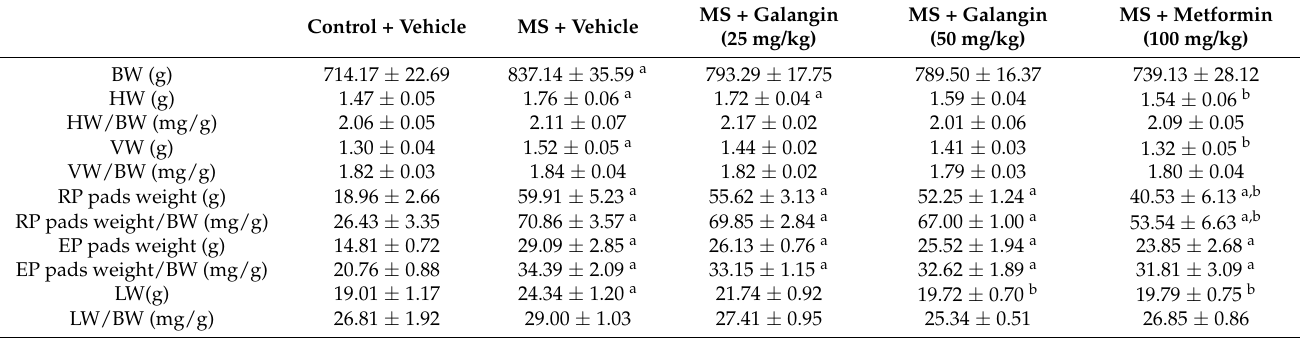
Table 1. Effects of galangin and metformin on body and organ weight in metabolic syndrome rats. Control +